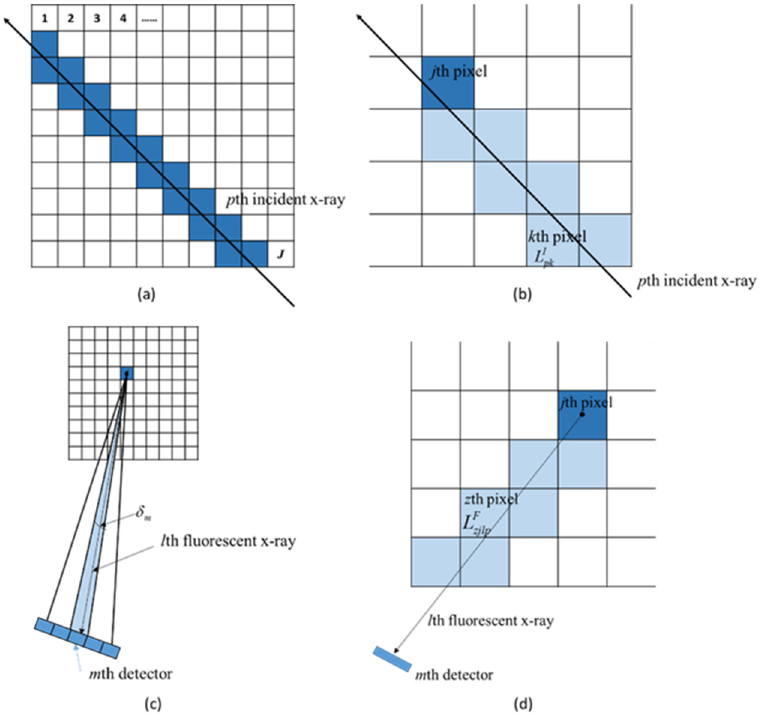
Figure 3. The parameters defined for discrete presentation. ( a ) example of a set S p defined for the p th incident at n th projection direction. ( b ) example of a set S pj defined for light blue squares intersected by the p th incident X-ray. ( c ) definition of δ m . ( d ) example of a set T zjlp defined for the p th incident x ‐ ray, the j th pixel, l th fluorescent x ‐ ray and m th detector. T zjlp consists of light blue squares intersected by the l th fluorescent x ‐ ray.